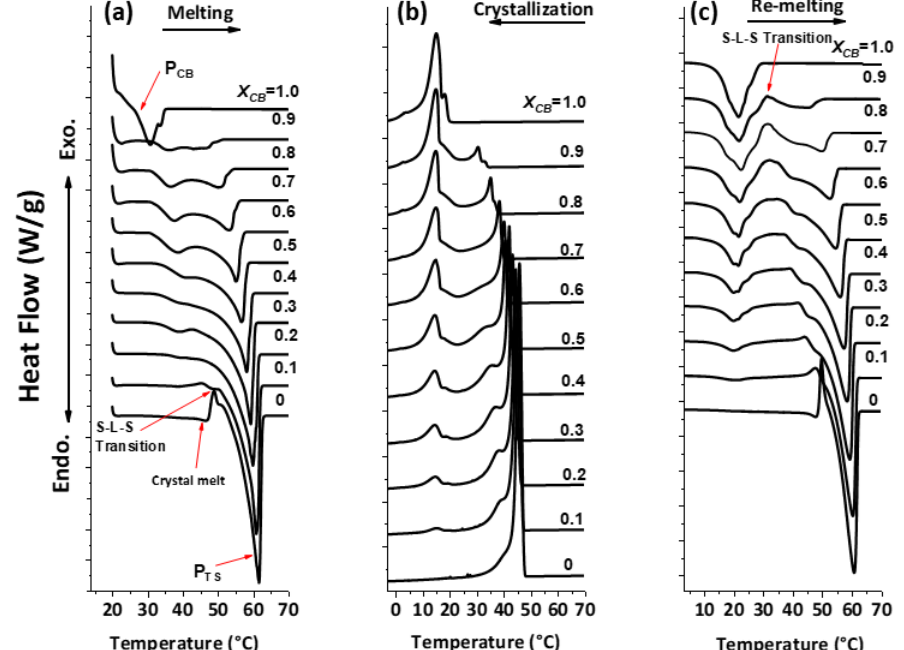
Figure 2. Differential scanning calorimetry (DSC) analysis of cocoa butter (CB)/tristearin (TS) (CB/TS) blends. ( a ) Melting process after crystallization for 24 h at 22 °C. The arrows indicate the peak of CB (PCB), the peak representing TS (PTS) and α polymorph melting. ( b ) Dynamic crystallization from 90 °C to −50 °C. ( c ) Remelting of crystals formed in segment ( b ). Arrow indicates the S–L–S (Solid–Liquid–Solid) transition.